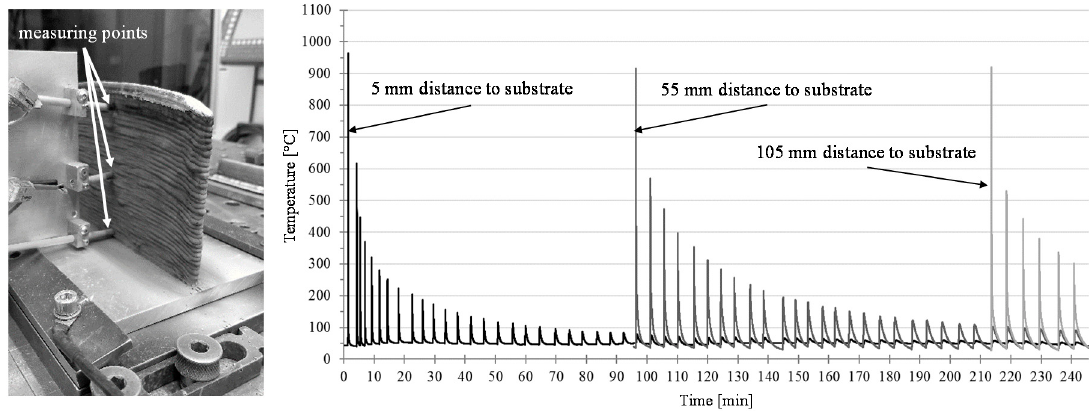
Figure 12. ( Left ) Representation of the temperature measuring points and ( Right ) the recorded temperature – time curve for the different temperature measuring points.